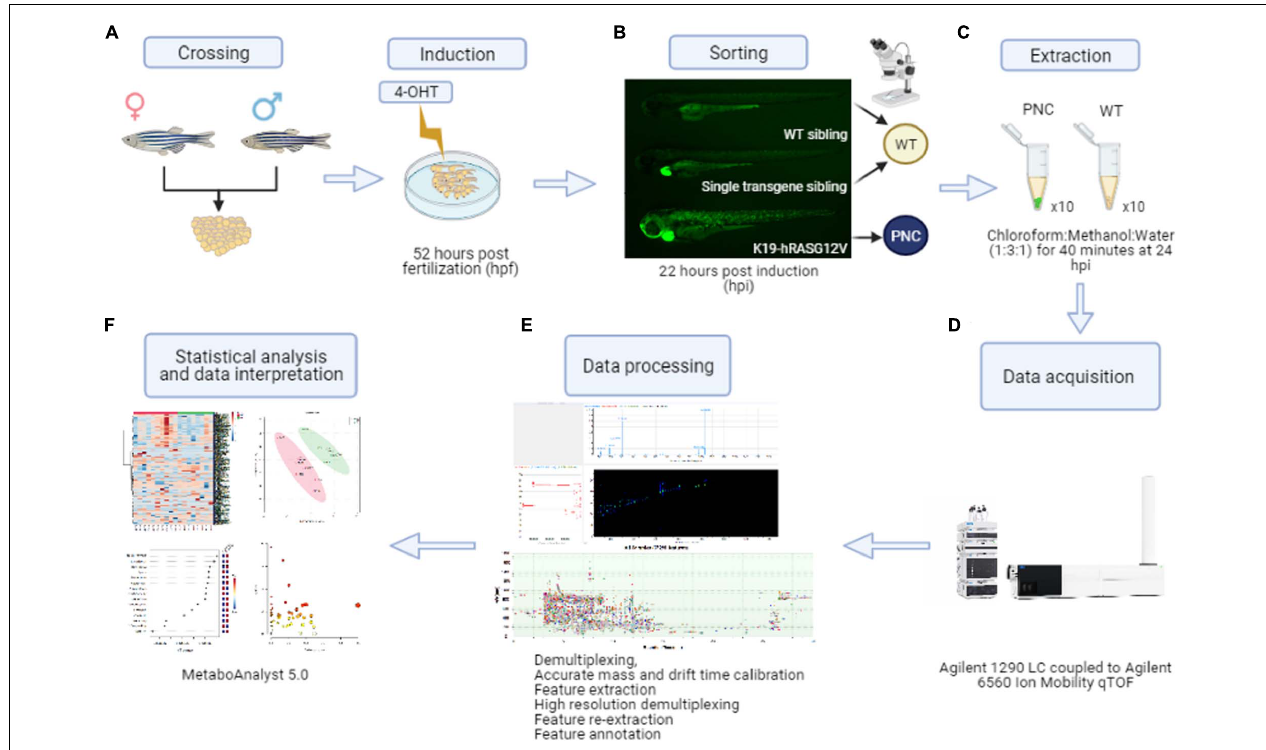
FIGURE 1 | Preneoplastic cell (PNC) induction and schematic workflow for untargeted metabolomics from zebrafish larval skin. (A) Adult K19:Gal4 driver fish were crossed with UAS:RAS. Embryos were transferred to petri dishes containing 4-OHT induction solution at 52 hpf. (B) At 22 hpi larvae with eGFP positive skin cells were collected as the preneoplastic cell (PNC) group. Single transgene siblings (with a green heart but with GFP negative skin cells) and wild type siblings (negative for both green heart and skin cells) were collected as wild type sibling (WT) group. (C) Metabolite extractions were carried out at 24 hpi. (D) Metabolites were detected by liquid chromatography coupled to ion mobility mass spectrometry LC-MS-IMS instrumentation. (E) Data processing was performed using the Agilent MassHunter 10 software suite. Feature extraction was performed using Mass Profiler 10.0 on the demultiplexed raw data fist, and after High Resolution Demultiplexing prior to feature annotation. (F) Finally, statistical analysis and data interpretation was performed using the web-based software MetaboAnalyst 5.0.